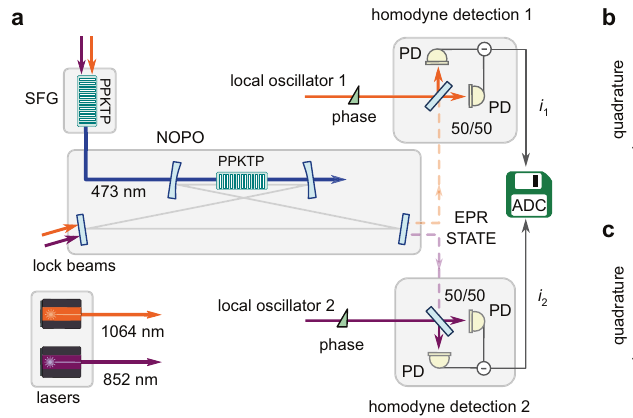
informationonthejointsystemoperators. b , c Theexperimentalrealizationsofthe photocurrents i 1 and i 2 showing strong non-classical correlations of { x 1 , x 2 } and { y 1 , − y 2 } for modes of two colours separated by 200nm. Here the signals were demodulatedat200kHzandintegratedbya10kHzlow-pass fi lter.Thequadrature values are in vacuum state